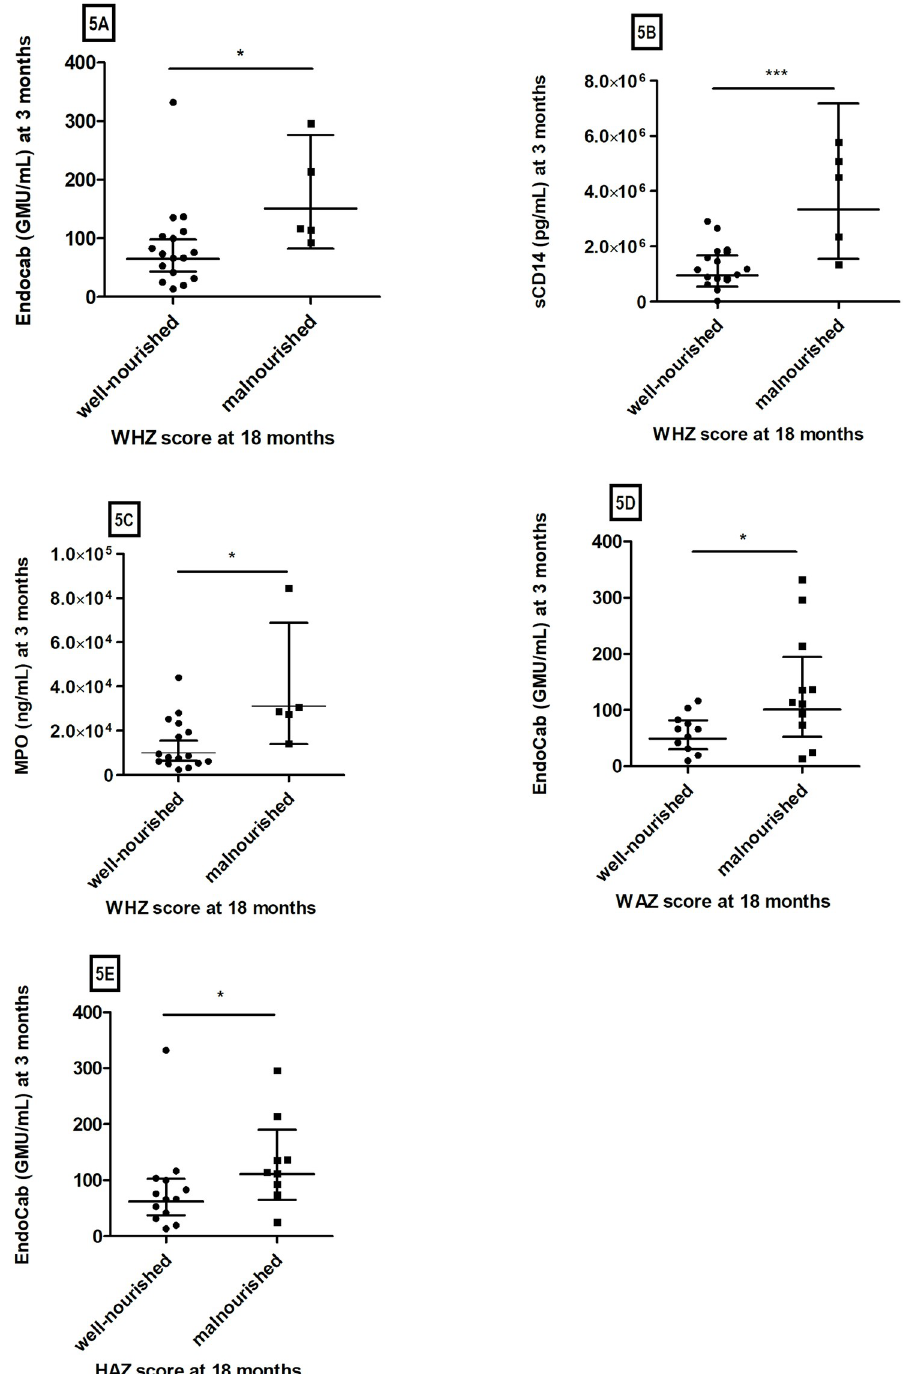
Fig 5. Association of serum EndoCab, sCD14, and fecal MPO levels with nutritional status. The X-axes show nutritional status (5A, 5B, 5C, 5D and 5E) and the Y-axes show EndoCab concentrations (GMU/mL) (5A, 5D and 5E), sCD14 levels(5B), and MPO levels (5C) at 3 months. Data are presented as geometric mean with 95% confidence intervals (CI). We performed the Mann Whitney test for statistical analysis of the data [ � P = 0.03(5A), ��� P = 0.001 (5B), � P = 0.01(5C), � P = 0.03(5D), and � P = 0.05(5E)].